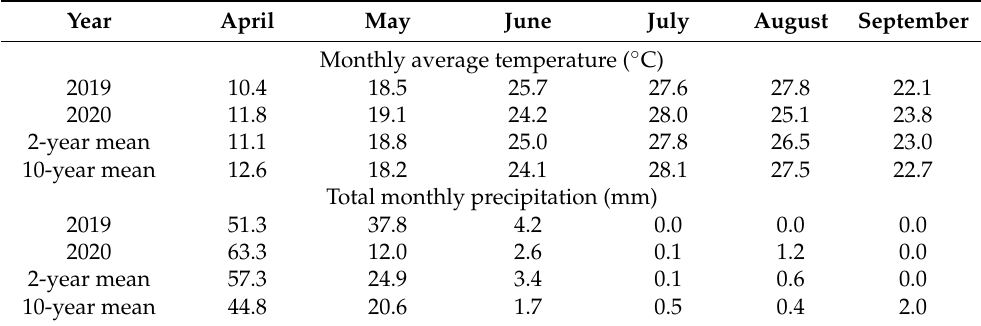
Table 9. Monthly average temperature and total monthly precipitation in 2019 and 2020 growing seasons and long-term averages in the experimental